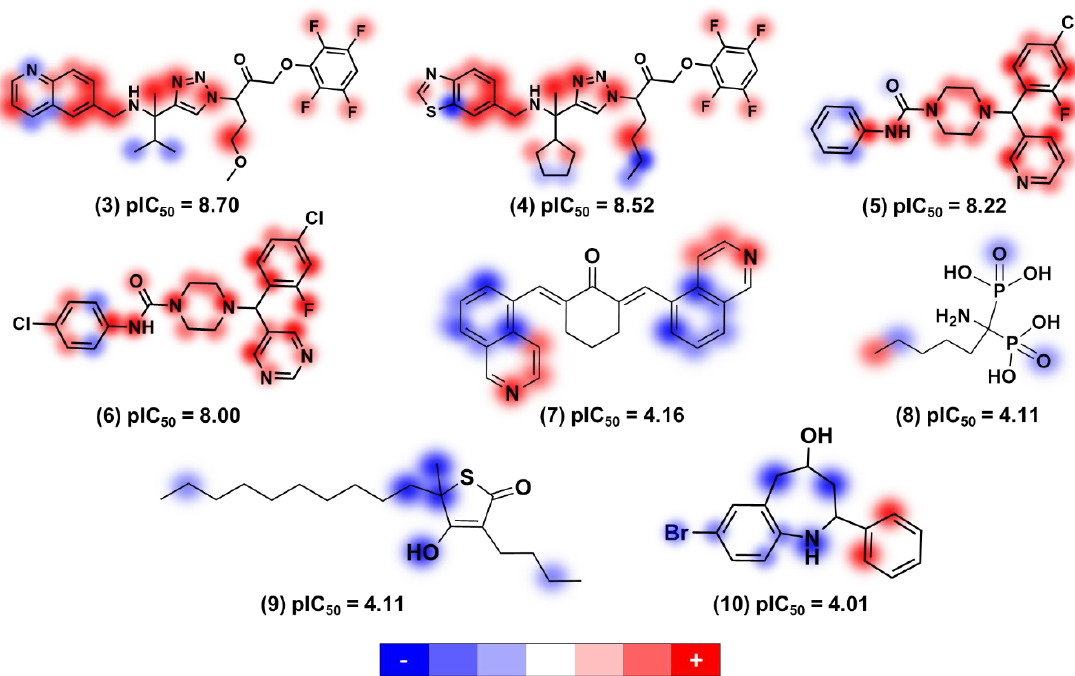
Figure 7. Contribution maps based on the molprint2D model (Table 5) for some dataset compounds located at both ends of the trypanocidal activity range.